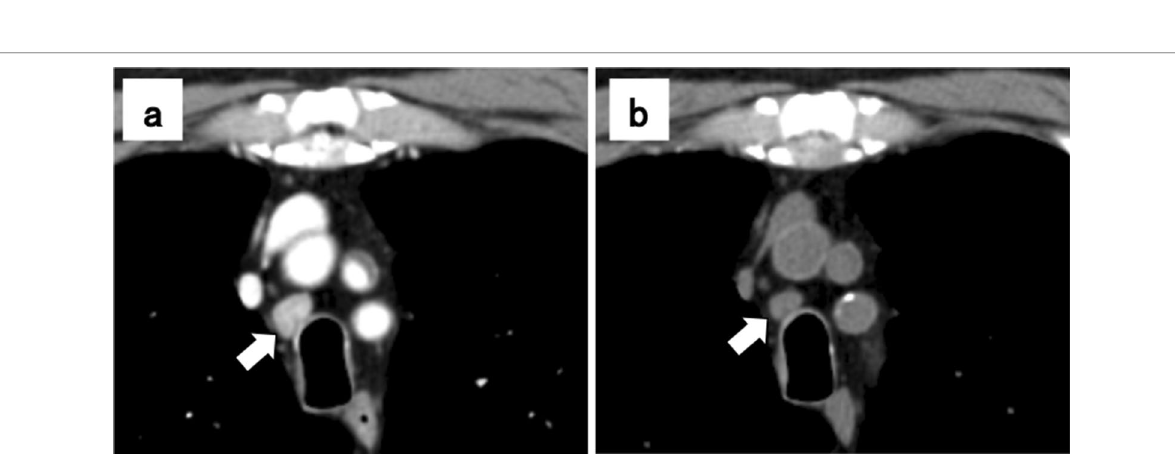
Fig. 3 Computed tomography images of the upper mediastinal lymph node metastasis before ( a ) and after 2 months of lenvatinib treatment ( b